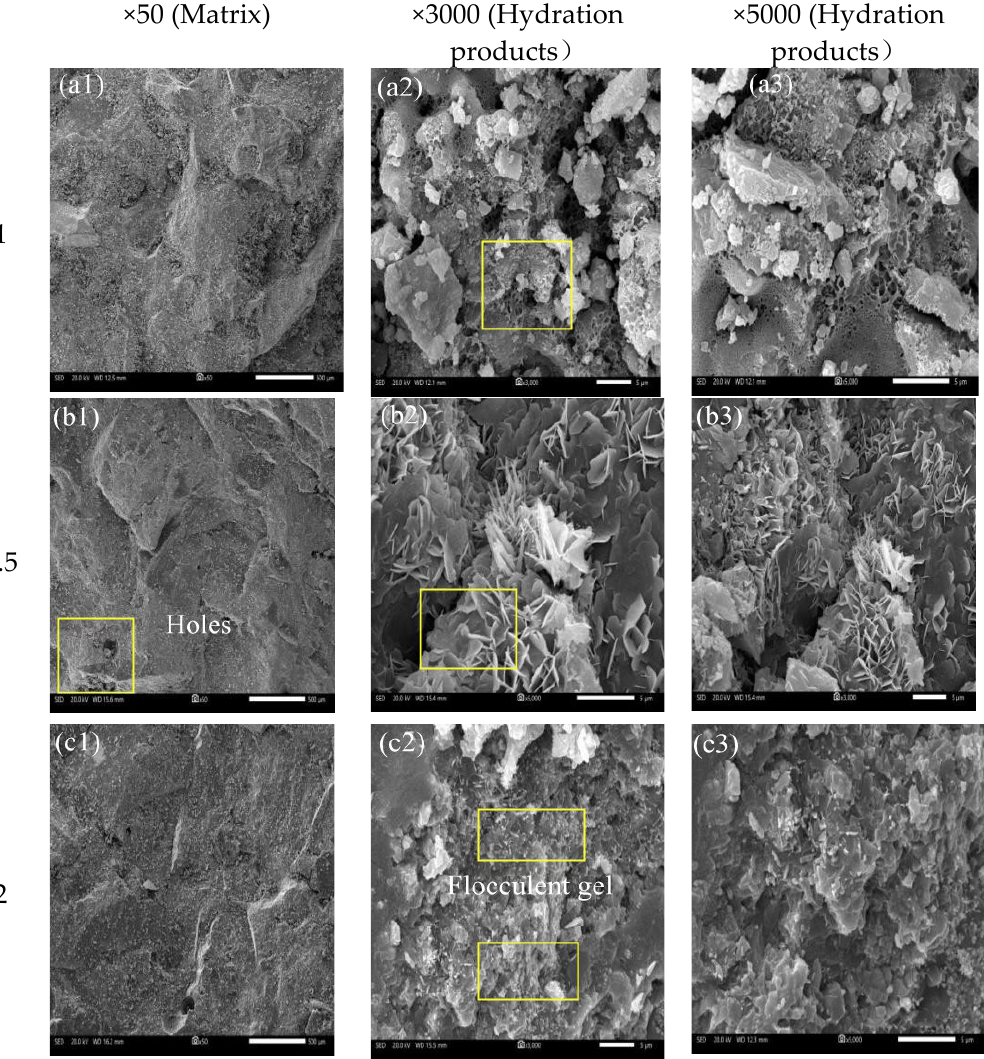
Figure 13. SEM images of AASSC with different modulus.